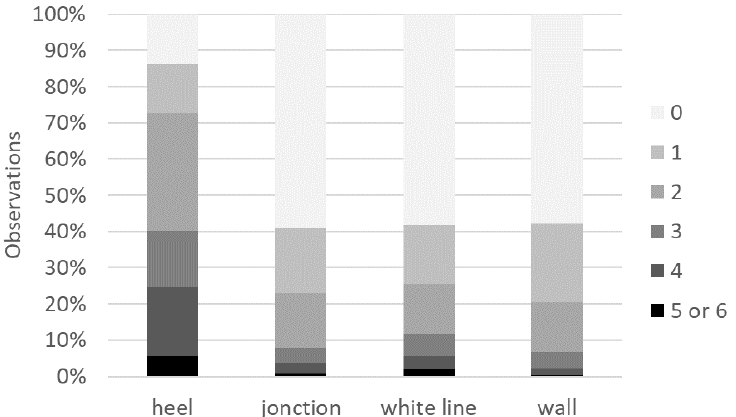
Figure 4. Frequencies of claw lesion scores (from 0—no lesions to 6—severe lesions) according to the area of the hind claw.